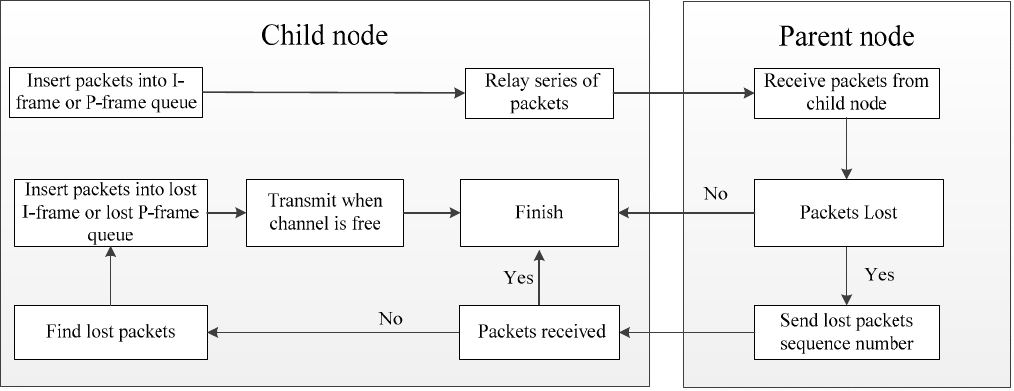
Figure 6. Retransmission mechanism.